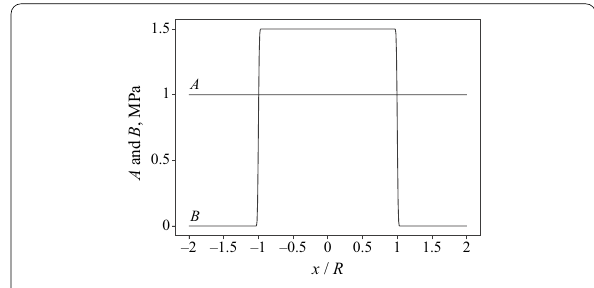
Fig. 4 Distributions of frictional parameters A and